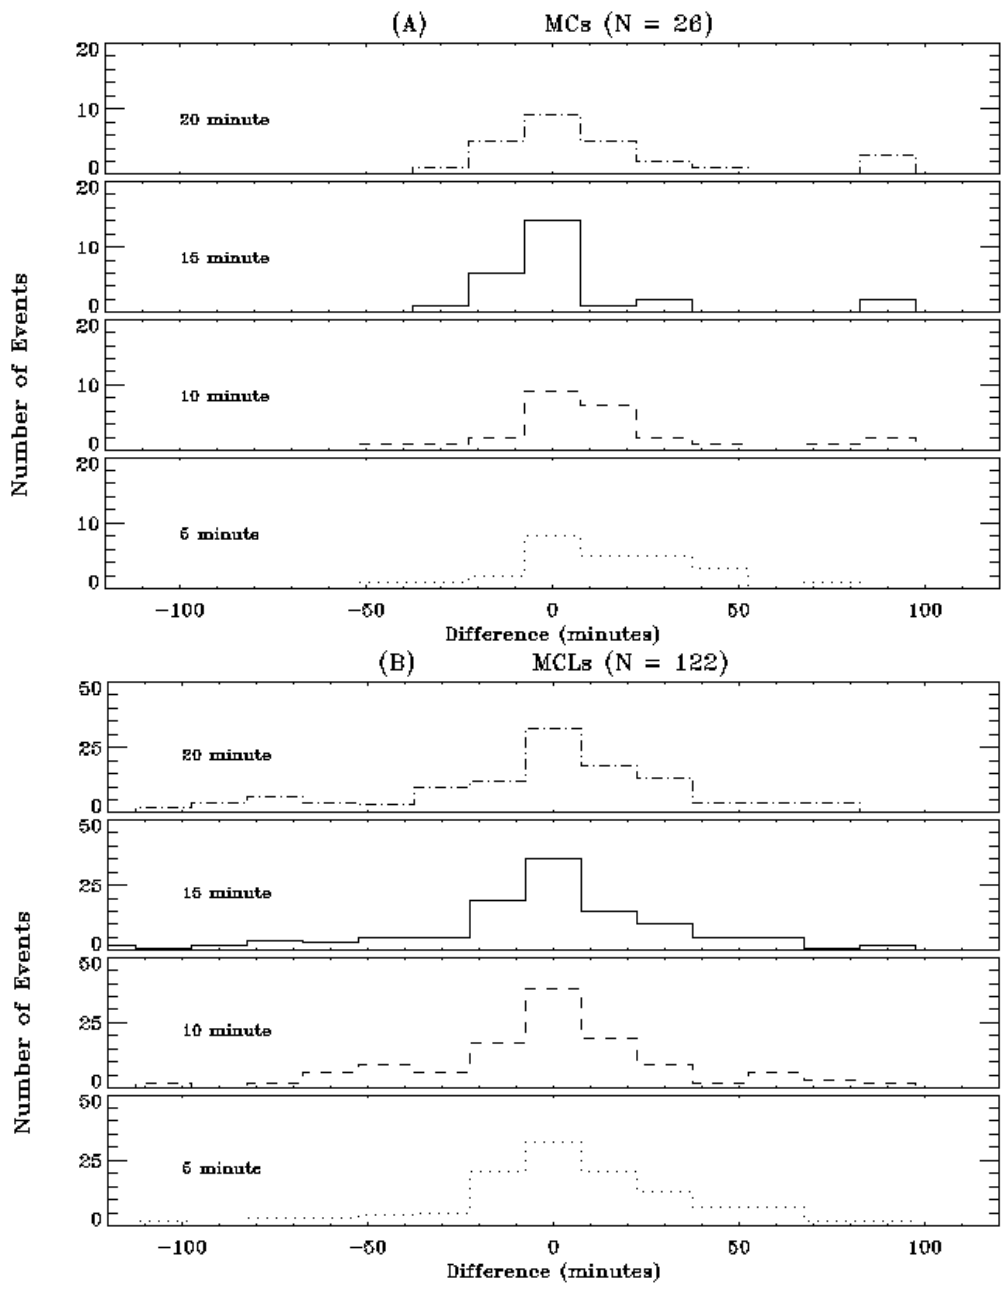
Fig. 3. (A) Histograms giving the number of WIND MCs (Data Set #1) that fall into time-differential buckets, where Difference refers to 1t =[ t B *(test)– t B (VI)]. The scheme for the display of type of averages is the same as used in Fig. 2a, b. (B) Similar to (A) except the histograms apply to the N =122 MCL (Data Set #2) events and Difference refers to 1t 0 =[ t B *(test)– t B